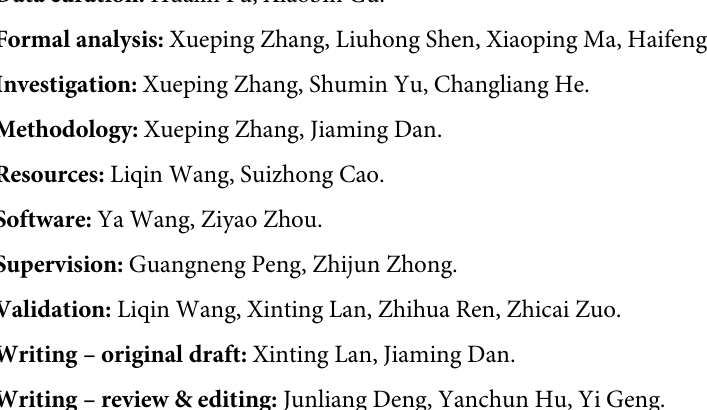
S2 Table. Variations in bg , tpi and gdh nucleotide sequences among the subtypes of Giardia duodenalis assemblage B from